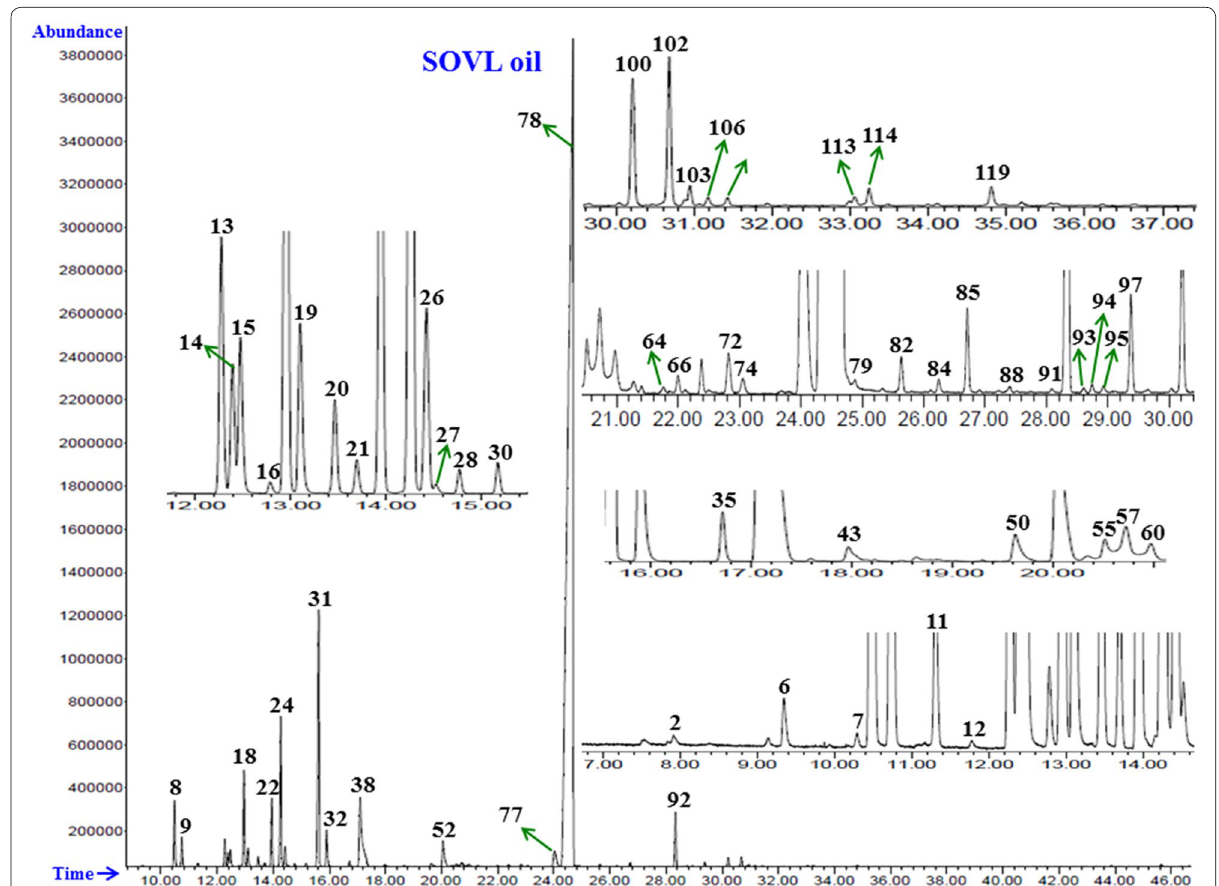
Fig. 1 GC–FID chromatogram of essential oil from the leaves of Saudi O. vulgare L. obtained using an HP-5MS column. The characterized peaks are numbered according to the serial numbers in Table